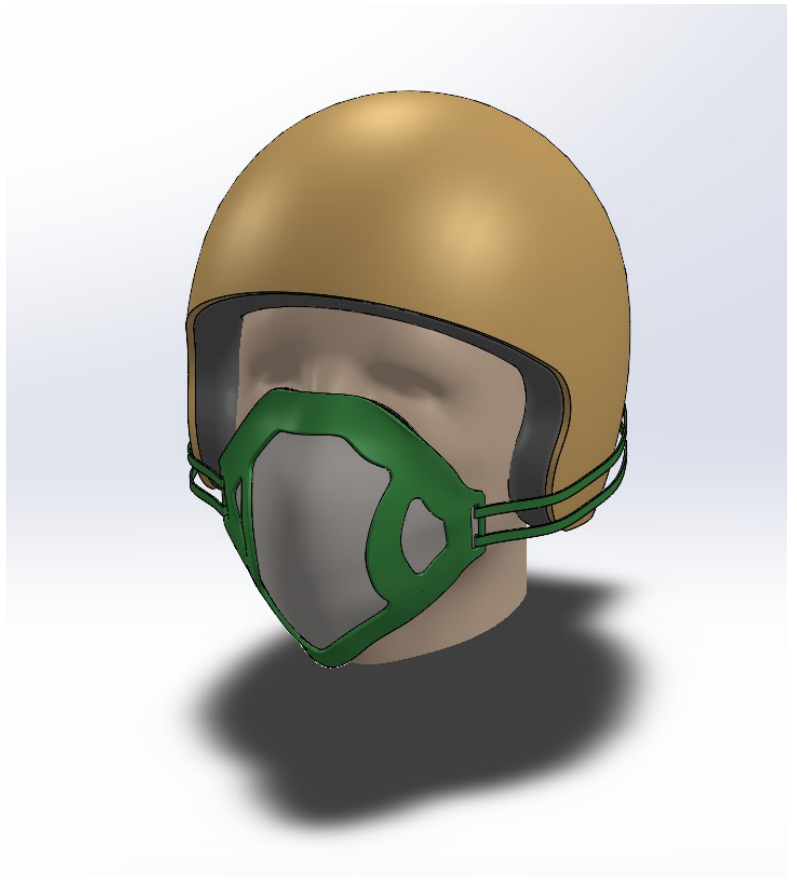
Figure 15. 3D render of a person wearing the mask